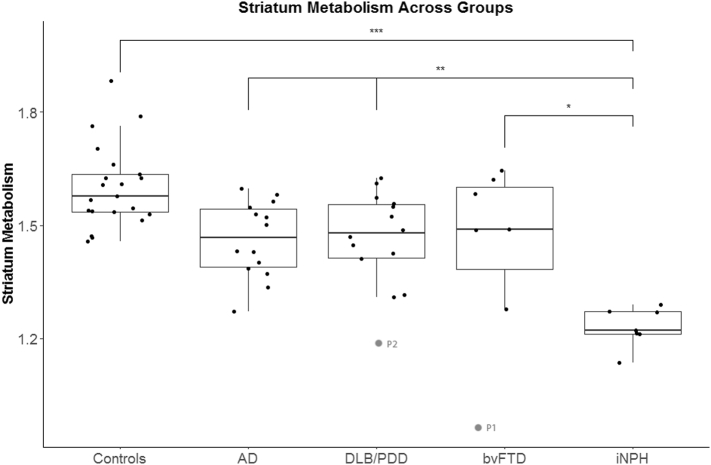
Box plot comparing striatum metabolism (a standardized ratio to the pons) across diagnostic groups. Area within the box indicates the 25th–75th percentile, the line within the box the median, the line outside the box the range between 1.5 standard deviations of the mean, and the solid circles indicate the individual cases for each group. The outliers are labeled P1 and P2 and included in the analysis. They are discussed in detail in the supplemental material. ⁎⁎⁎indicates highest significance CN > NPH (p < 0.0001). ⁎⁎Indicates high significance with DLB/PDD > NPH (p = 0.0020), AD > NPH (p = 0.0022). ⁎indicates moderate significance, FTD > NPH (p = 0.0387).